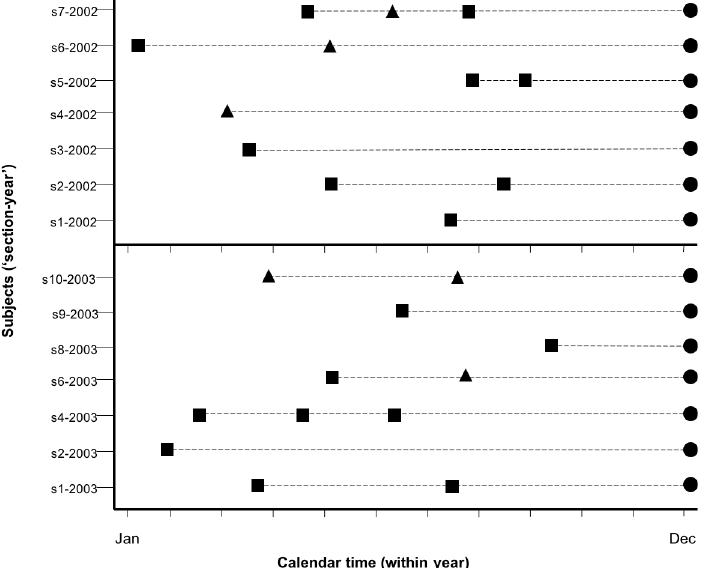
Fig 3. Transforming depredation records to a survival analysis format. We presentlethalinterventions (triangles) andnon-lethalinterventions(squares)connectedby a dashedlinethat measures the delayto recurrence or censorship(circles).We illustrateusingdatafrom twosubsequent years. Subjects are identified as combinations of vicinity(section,townshiporneighborhood) andyear(i.e.: sections1-2002)on the y-axis. The first figurefor eachsubjectrepresentswhenthe first depredation eventin that yearoccurred,whichis the date follow-up started for that ‘section-year’. Eachsubjectthen followsa chronology of subsequent depredationevents throughthe year, treatedwith eitherintervention. Stratum 1 considers the initialinterventionimplementedandthe delayto recurrenceto the next depredationevent, or censoring if no othereventsoccurred(i.e.: first figureto secondfigureindashedlinefor each subject). Stratum2 considersthe nextsequenceof depredationevents(i.e.: delayfrom secondfigureto third figure).Dueto ourconstructionof subjects,a particular section(sections1, 2, 4 and6, for example)canappearinmultipleyears,representedwith a different ‘section-year’ combination (for